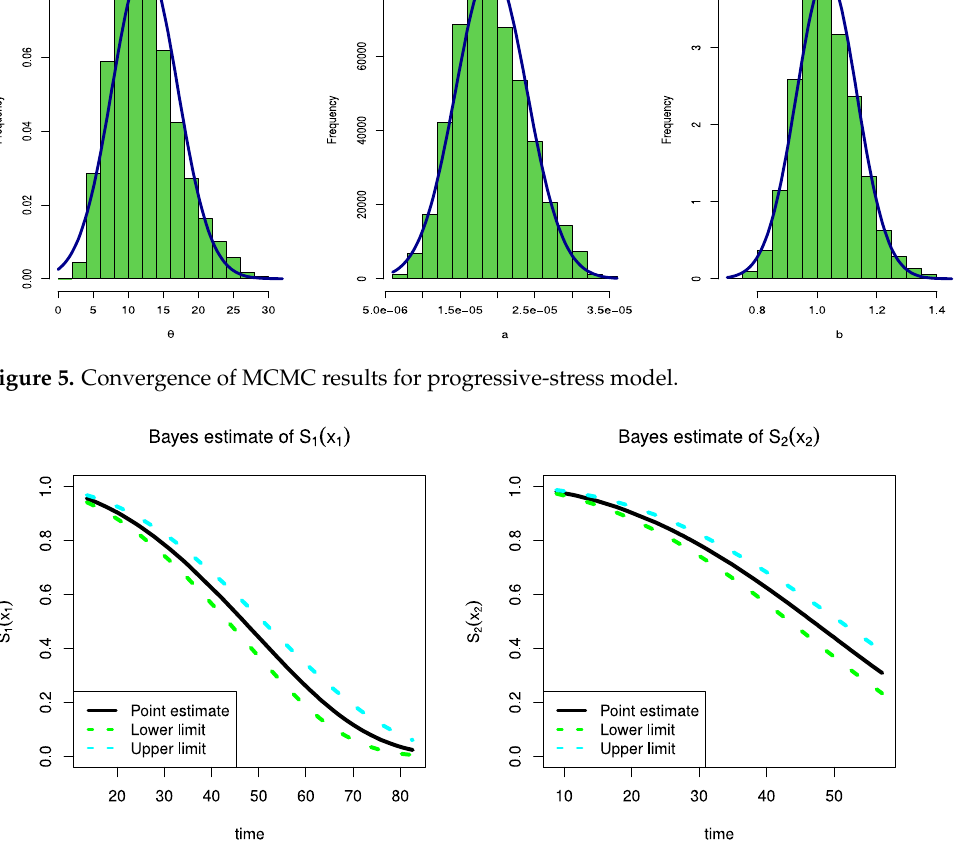
Figure 6. Bayes point and interval estimates of the sub-survivor functions and the overall sur- vivor